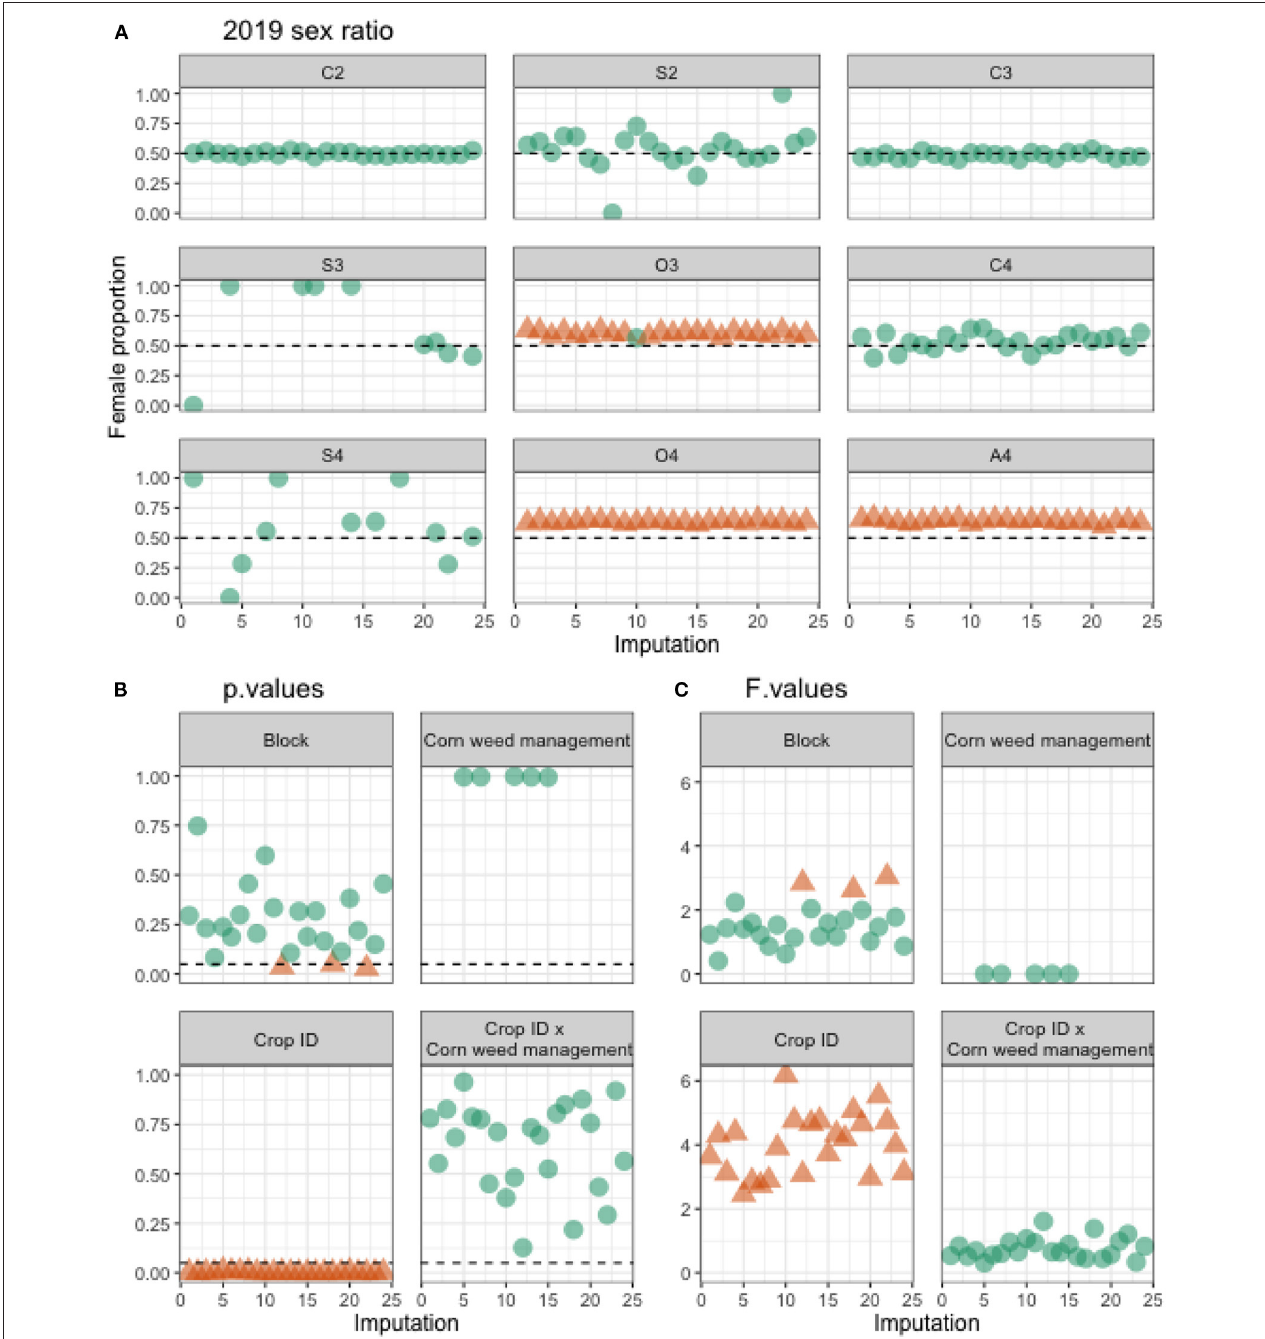
FIGURE 4 | Waterhemp population sex ratios under nine crop identities averaged over two Corn weed management regimes using 2019’s 24 imputed data sets (A) . The abbreviations on the (A) ’s sections are crop identities, which are the combinations of the first letter in crop species names and the rotation to which the crops belonged (C2, corn in the 2-year rotation; C3, corn in the 3-year rotation; C4, corn in the 4-year rotation; S2, soybean in the 2-year rotation; S3, soybean in the 3-year rotation; S4, soybean in the 4-year rotation; O3, oat in the 3-year rotation; O4, oat in the 4-year rotation; and A4, alfalfa in the 4-year rotation). The dashed lines mark sex ratio parity in (A) and level of confidence in (B) , respectively. The blank spaces are nonestimable values. The triangulars and circles in (A) represent female-biased and even populations assessed at alpha = 0.05, respectively. F-ratios for sources of variation are shown in (C) .